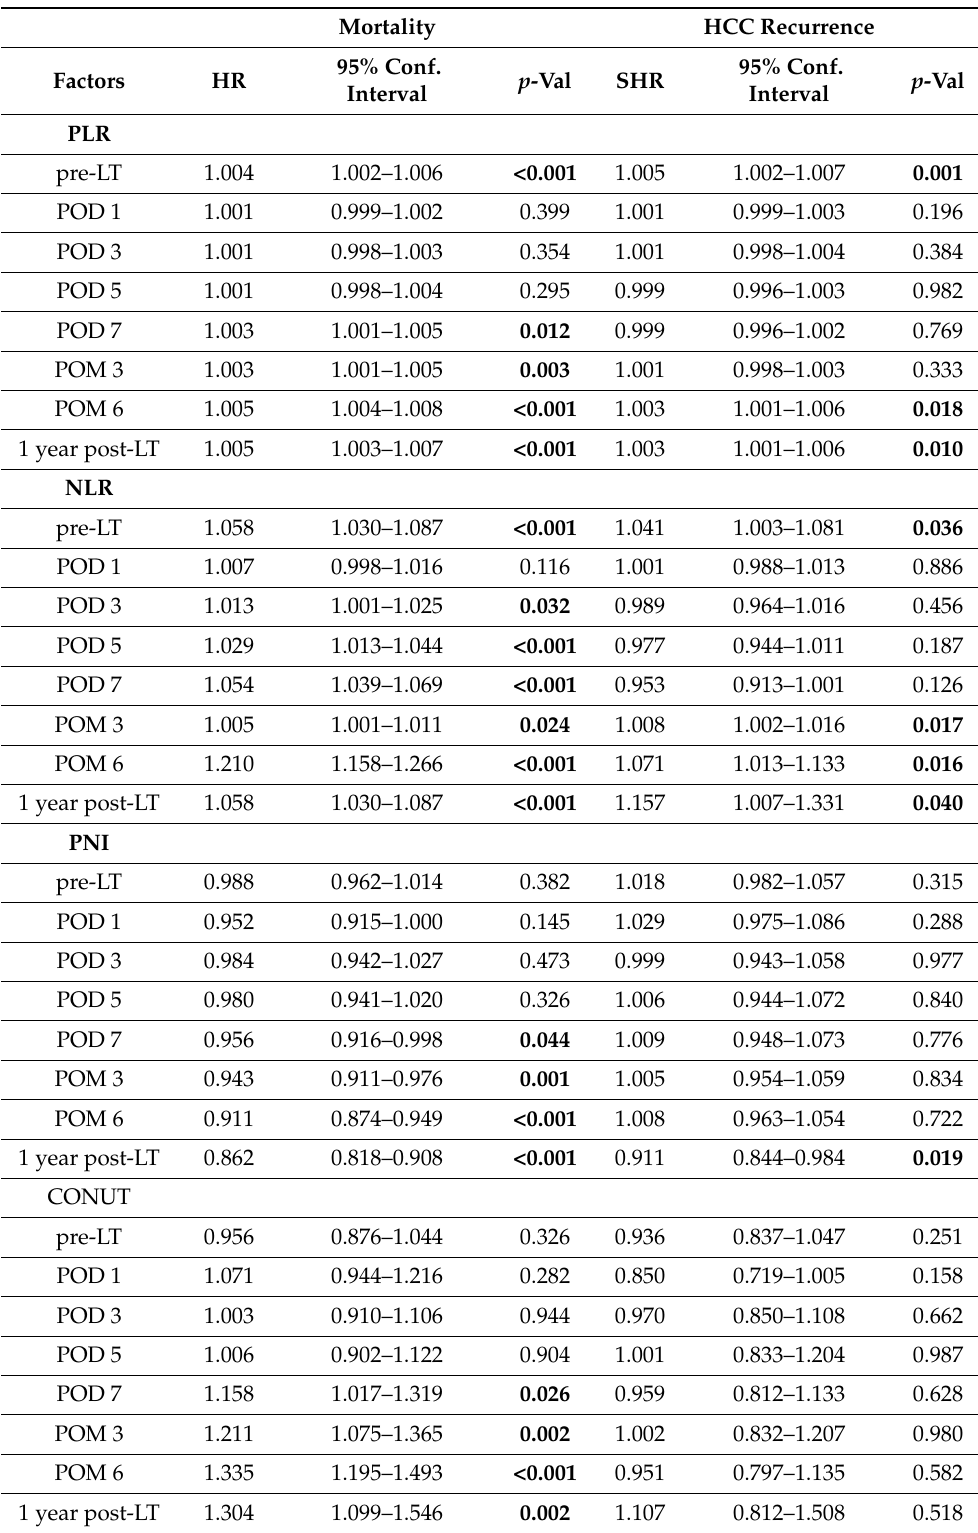
Table 2. Univariate analysis of prognostic value for mortality and tumor recurrence of inflammatory and nutritional biomarkers, pre- and post-LT, in the whole study population ( n = 324). Mortality HCC